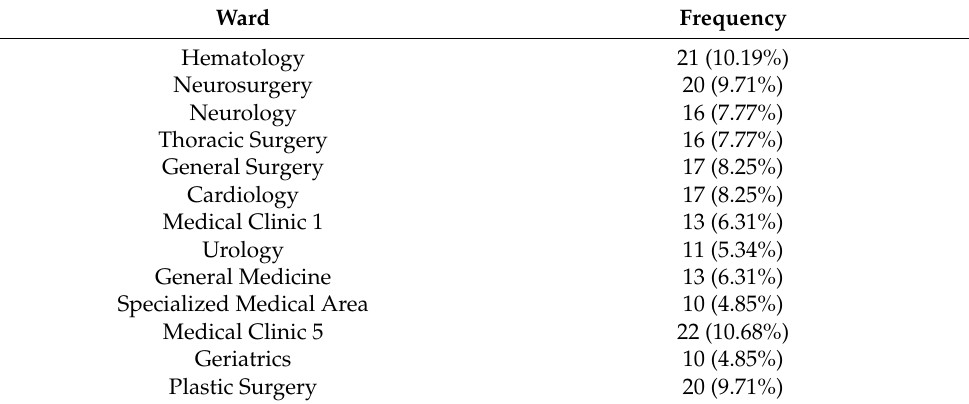
Table 1. Distribution of respondents by hospital ward.